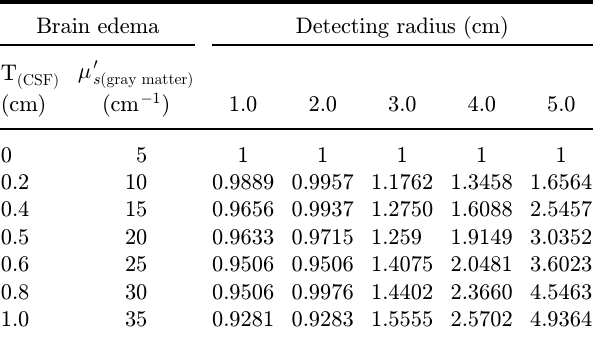
Table 2. The normalized light intensity in Model 1 0 . Brain edema